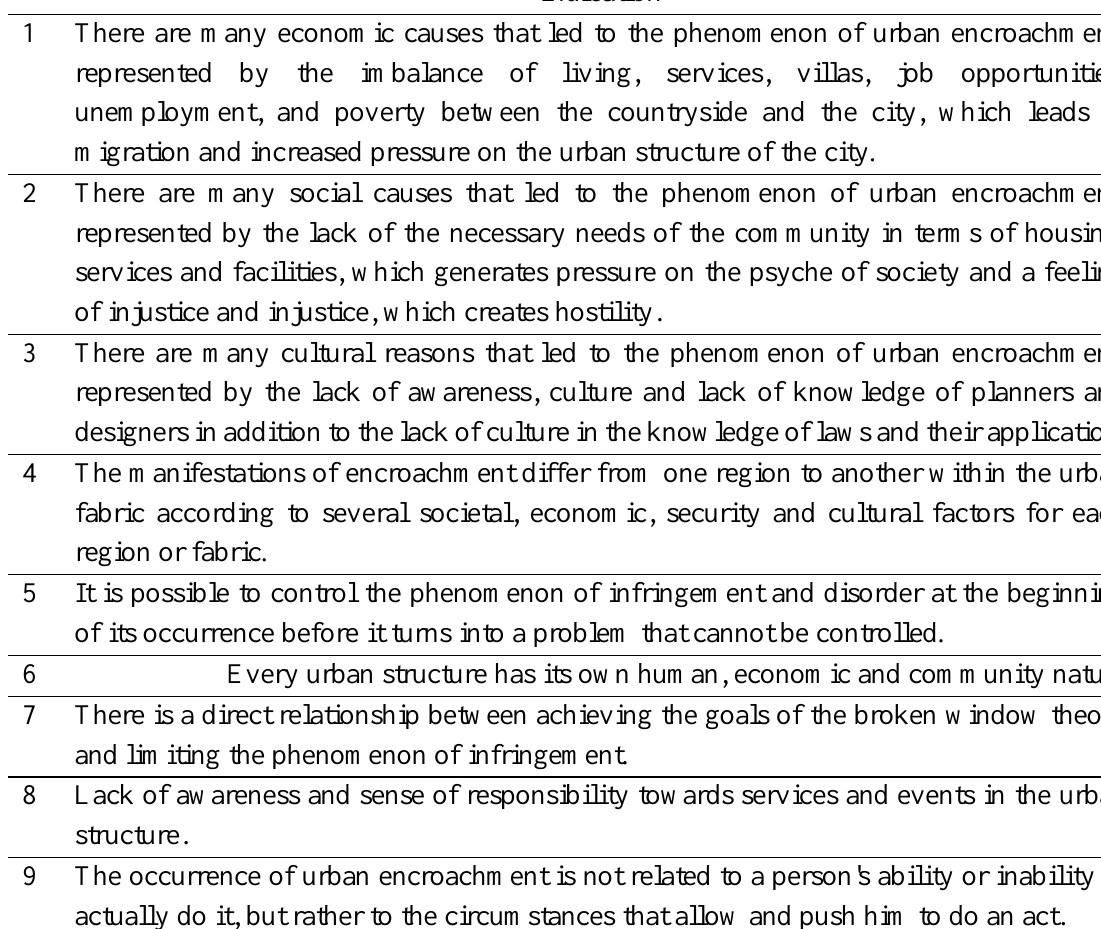
Table 4. Interpretation of urban trespassing indicators in the light of the theory / source of broken windows: the researcher focused on previous theory and phenomenon